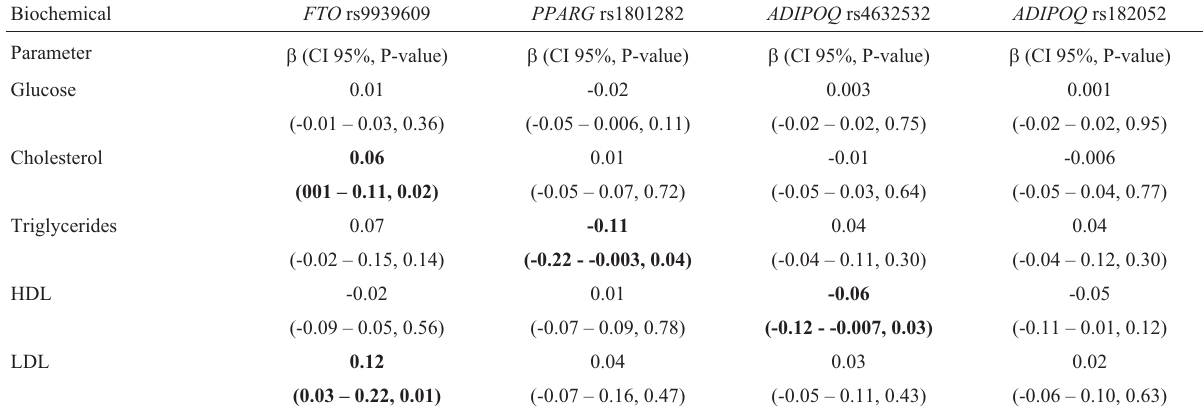
Table 5 - Association of polymorphisms with biochemical parameters